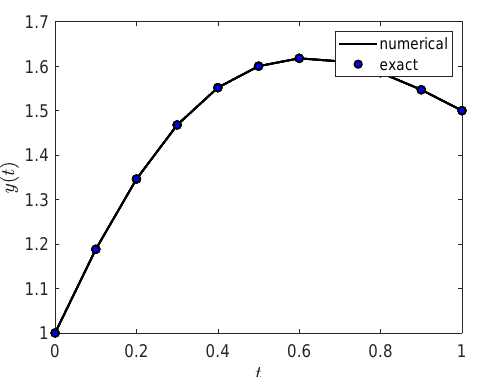
Figure 4. Graphs of the exact and approximate solutions for example